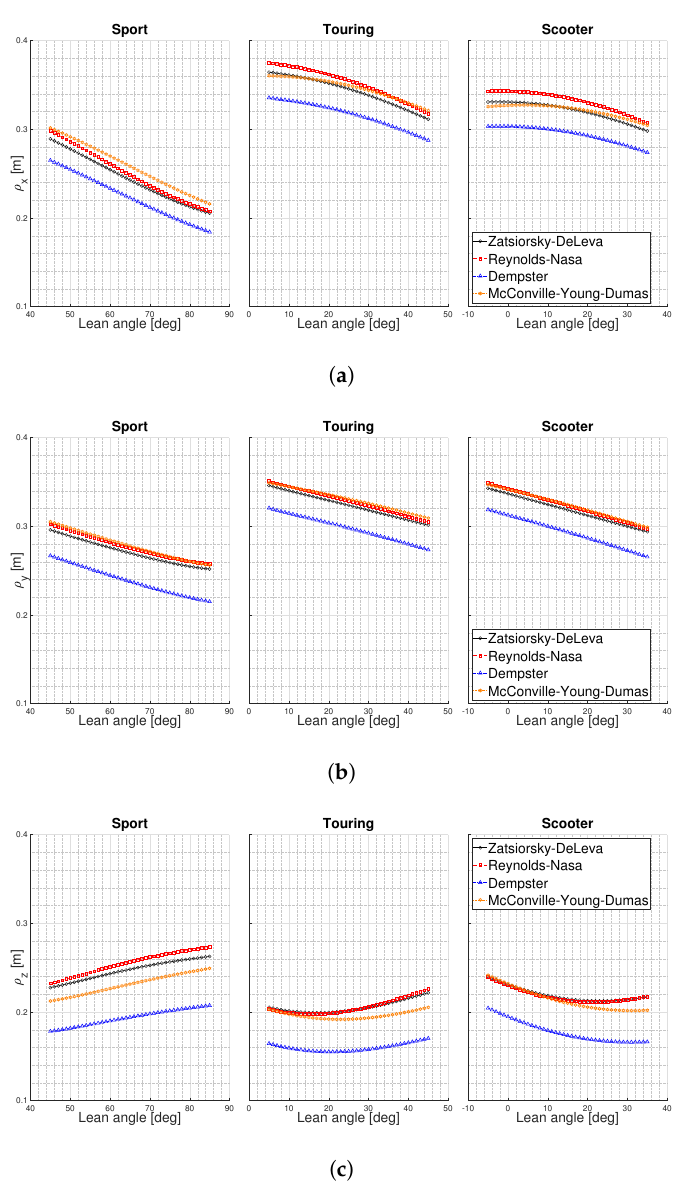
Figure 9. Roll ρ x ( a ), pitch ρ y ( b ), and yaw ρ z ( c ) gyration radii as a function of lean